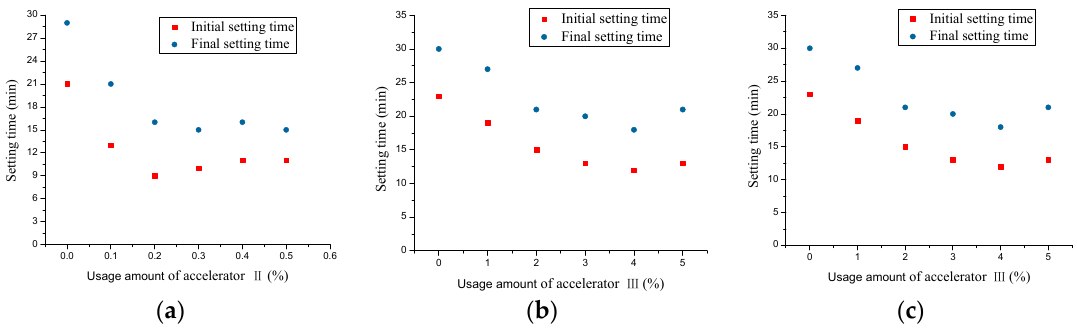
Figure 4. Setting time of grouting materials with different double mixing amounts: ( a ) accelerators I and II; ( b ) accelerators I and III; and, ( c ) accelerators II and III.